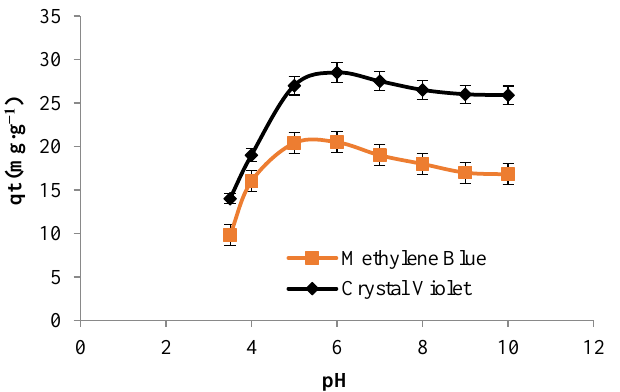
Figure 5. Effect of pH on the adsorption of: methylene blue and crystal violet (C 0 = 30 mg L −1 , Time = 30 min, T = 22 °C, Volume = 10 mL, and adsorbent dosage = 0.012 g) (For each measurement, 3 replicates are done).